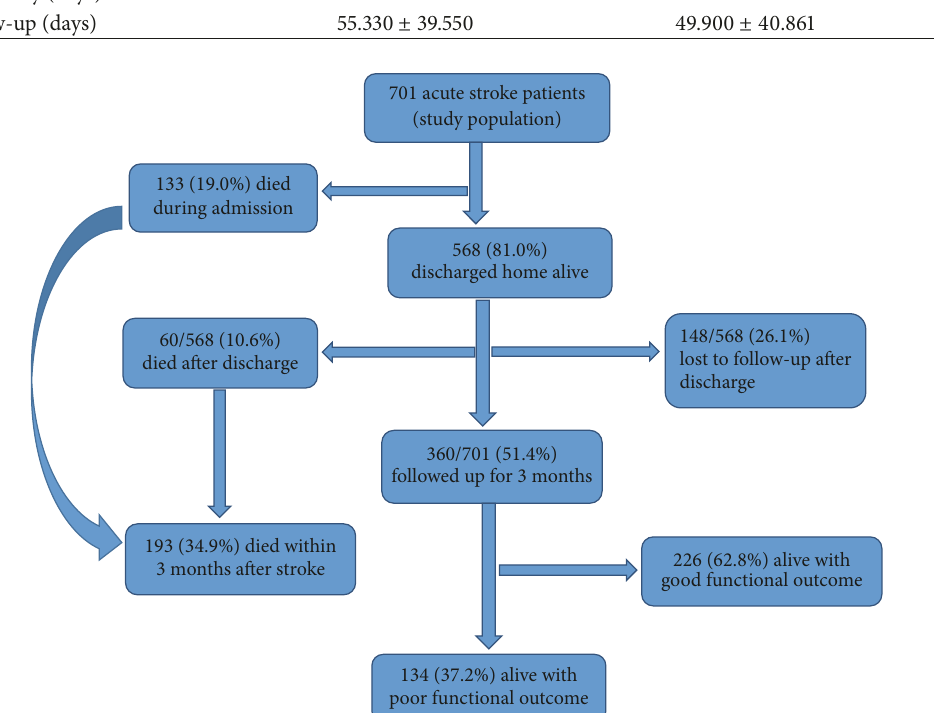
Figure 1: Flow chart of functional outcome and death during the 3-month